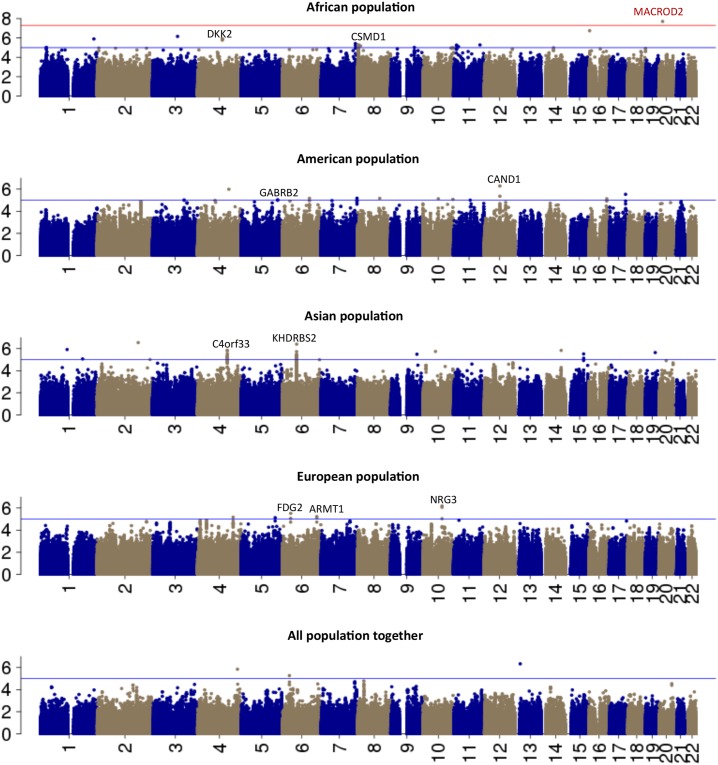
GWAS results Manhattan plot.Manhattan plots for Asian, African American and European population subsets showing top hits from each continent. The blue line indicates p-value of 10−5 and red line indicates p-value of 10−8.